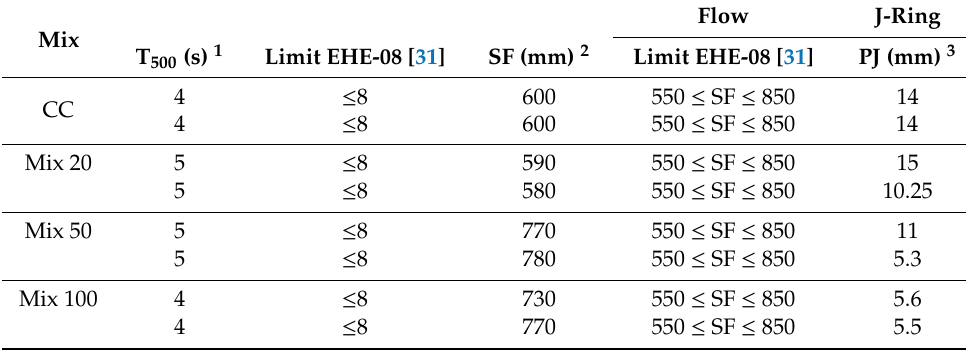
Table 7. Self-compactability of the samples designed.